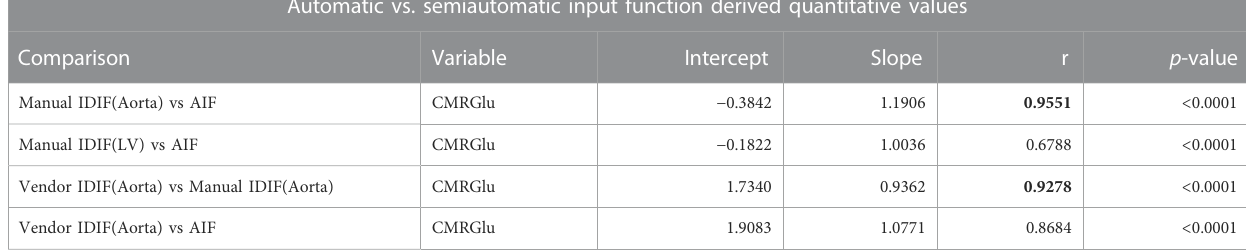
TABLE 2 Overview of correlation and regression parameters from kinetic modelling. Comparison of regional cerebral metabolic rate (CMRGlu) uptake of all participants derived from automatic (vendor) to manual and arterial input functions. The best correlation values before and after movement correction are depicted in